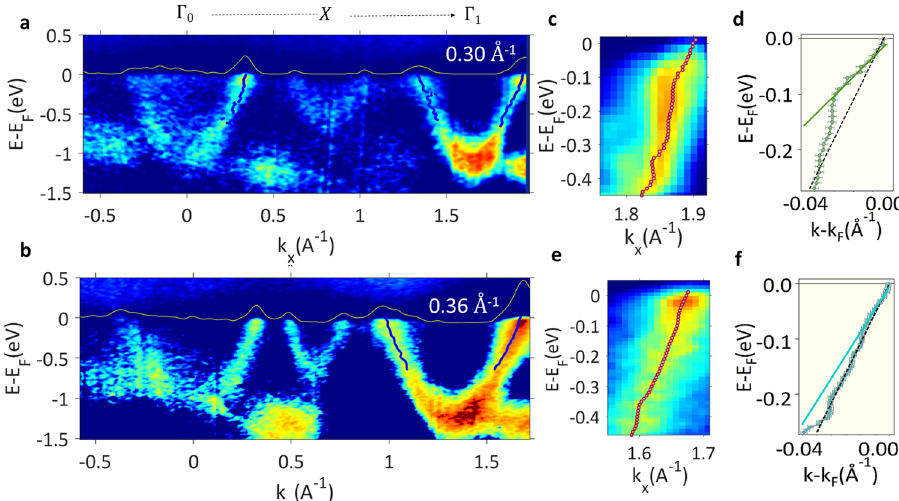
Fig. 3 Three-dimensional electron bands and their dispersion kinks. Angle-resolved photoelectron spectroscopy (ARPES) images recorded with the energy hv = 643 eV and p-polarized light along the Γ X direction, probing the electron bands for La 0.7 Sr 0.3 MnO 3 (LSMO) ( a ) and PbZr 0.2 Ti 0.8 O 3 (PZT) interface, PZT|LSMO ( b ). The momentum distribution curves (MDCs) at the Fermi energy (E F ) (yellow lines) are used to extract the Fermi wavevector (k F ) values. ( c ) Zoom-in of the ARPES images in the low-energy region, with the superimposed red dotted line showing the MDC maxima for LSMO surface. d Low-energy MDC maxima and their linear fi t corresponding to the bare and renormalized dispersions in the kink region for LSMO surface ( d ). e Zoom-in of the ARPES images in the low-energy region, with the superimposed red dotted line showing the MDC maxima for PZT|LSMO interface. f Low-energy MDC maxima and their linear fi t corresponding to the bare and renormalized dispersions in the kink region for PZT|LSMO interface ( f ) The error bars represent the standard deviation extracted from the MDC fi t with a combination of Lorenz distribution and smooth background.